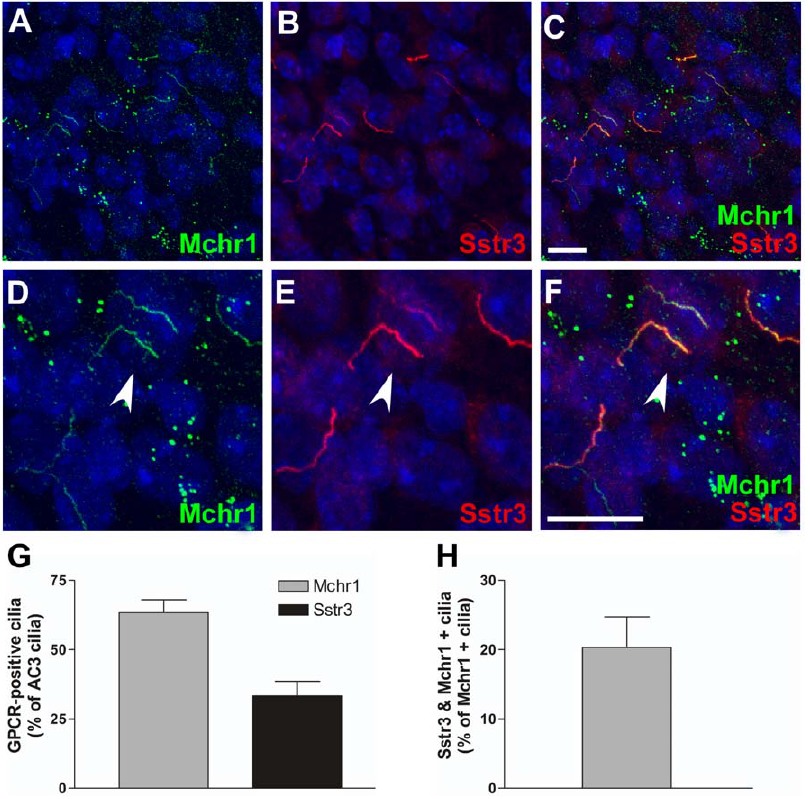
Figure 4. Mchr1 and Sstr3 colocalize in a subset of hypothalamic neuronal cilia. (A–F) Representative image of the hypothalamus from an adult WT mouse colabeled for Mchr1 (green) and Sstr3 (red). Nuclei are stained with DRAQ5 (blue). Labeling for Mchr1 (A) and Sstr3 (B) reveals the presence of Mchr1- and Sstr3-positive cilia in the hypothalamus. Merged image (C) shows colocalization of Mchr1 and Sstr3 on a subset of neuronal cilia. Zoomed in image (D–F) reveals a subset of neuronal cilia that are positive for both Mchr1 and Sstr3 (arrowhead). (G) Quantification of day 7 WT hypothalamic neurons colabeled for Mchr1 and AC3 or Sstr3 and AC3 reveals that Mchr1localizes to 63.42 6 4.59% (n=108) of AC3-positive cilia and Sstr3 localizes to 33.34 6 5.24% (n=129) of AC3-positive cilia. (H) Graphical representation of the quantification of day 7 WT piriform cortex neurons colabeled for Mchr1 and Sstr3 shows Sstr3 colocalizes to 20.36 6 4.39% (n=85) of Mchr1-positive cilia. Scale bars represent 10 m m.